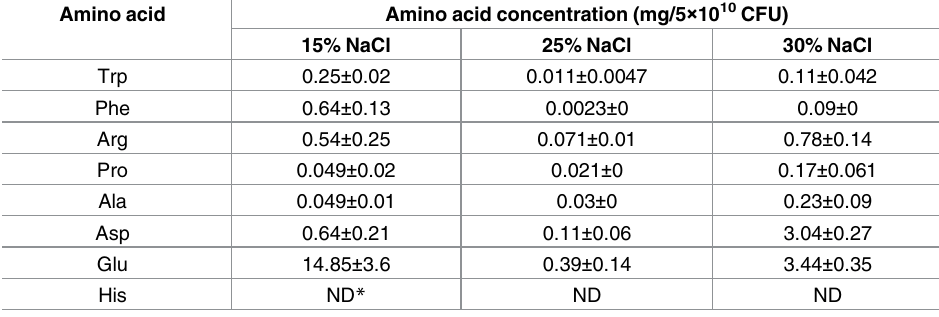
Table 3. Concentration of free amino acids of cells incubated at different